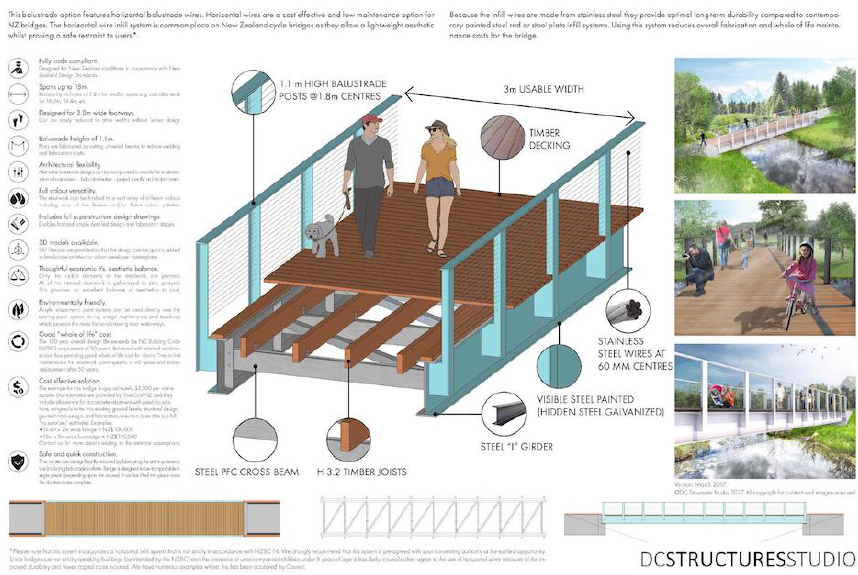
Fig. 1. New Zealand standard footbridge design (elementary 18 m pedestrian